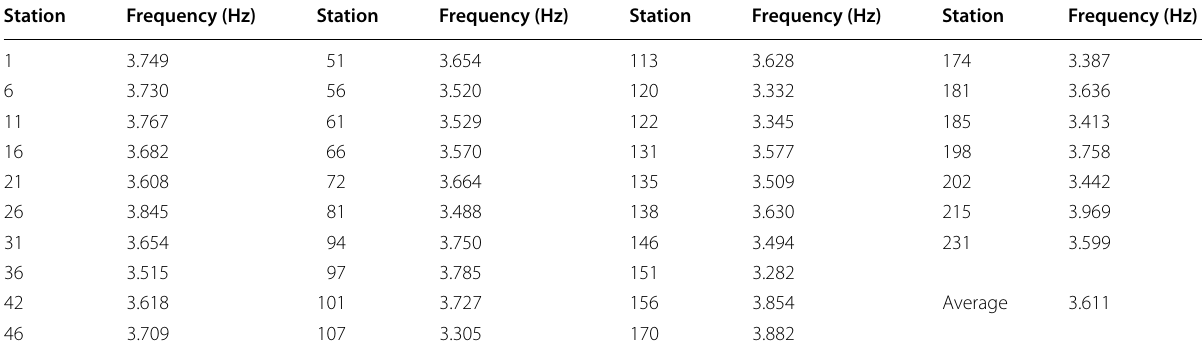
Table 2 The frequency corresponding to the amplitude spectrum of 37 stations (EW component) Station